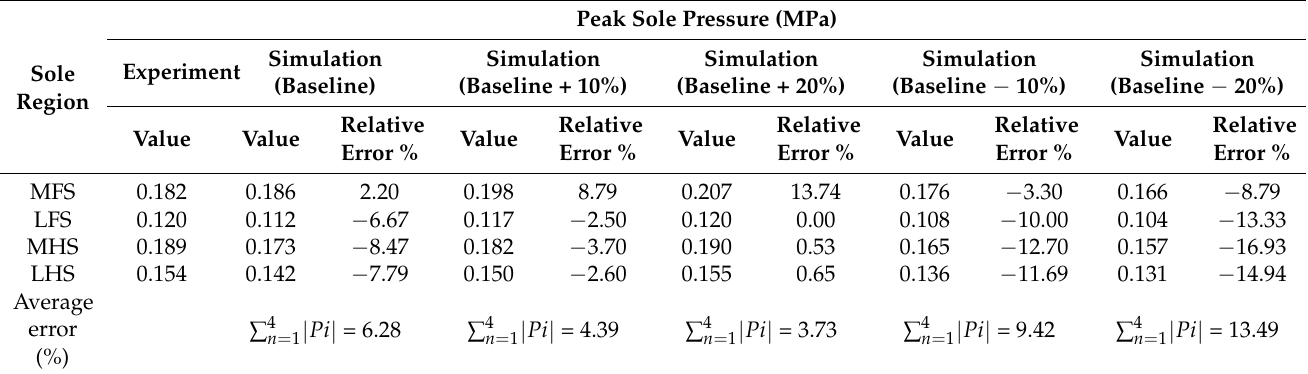
Table 3. Comparison of predicted peak sole pressures and experimental pressure plate data in 4 sole regions during balanced standing.